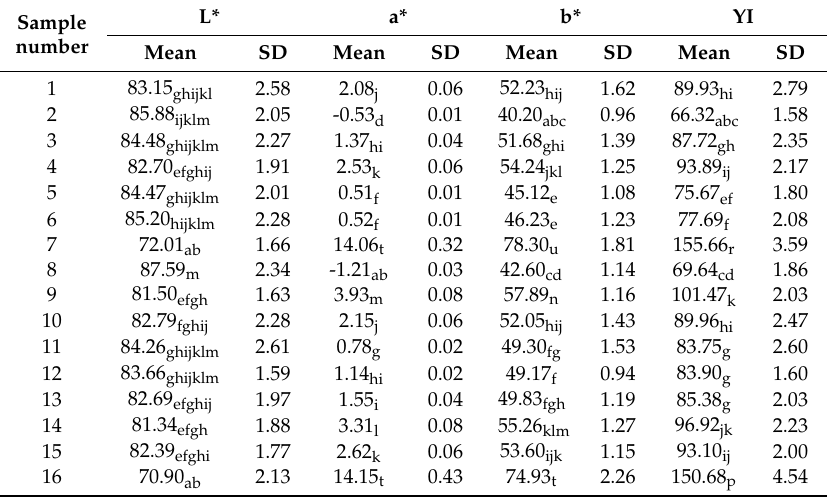
Table 1. Color parameters of the sweet mash samples